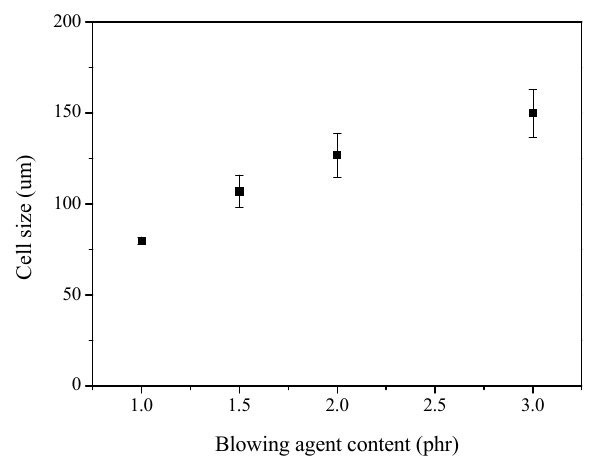
Figure 8. Cell size of polyoxymethylene (POM) foams as a function of blowing agent content,